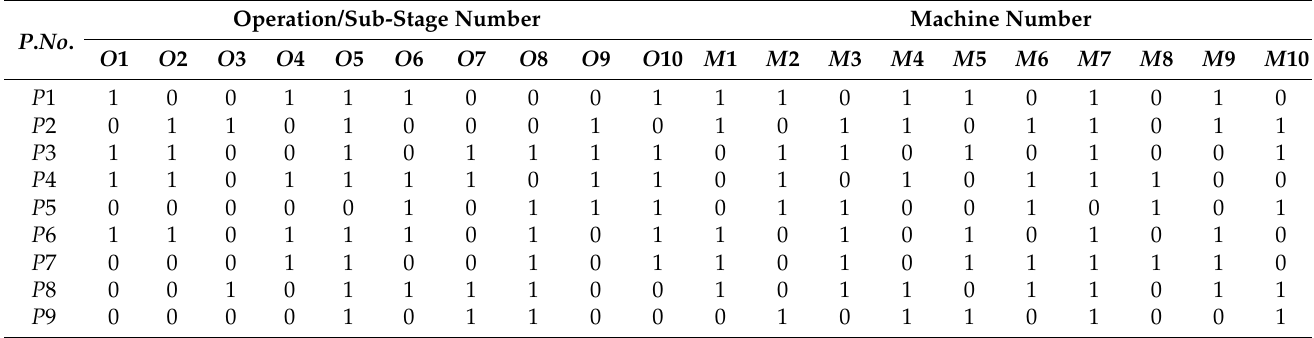
Table 7. Possible operation—process and process—machine feasibility matrix of knuckle joint assembly.